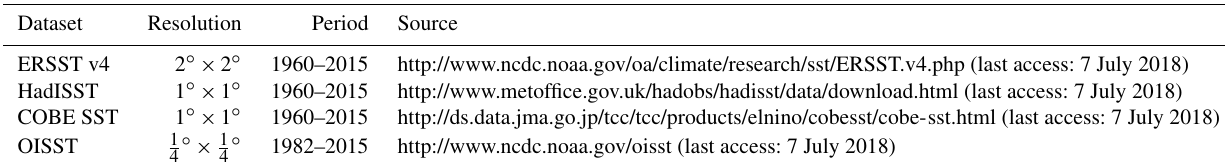
Table 1. Global gridded SST datasets used in this study. Dataset